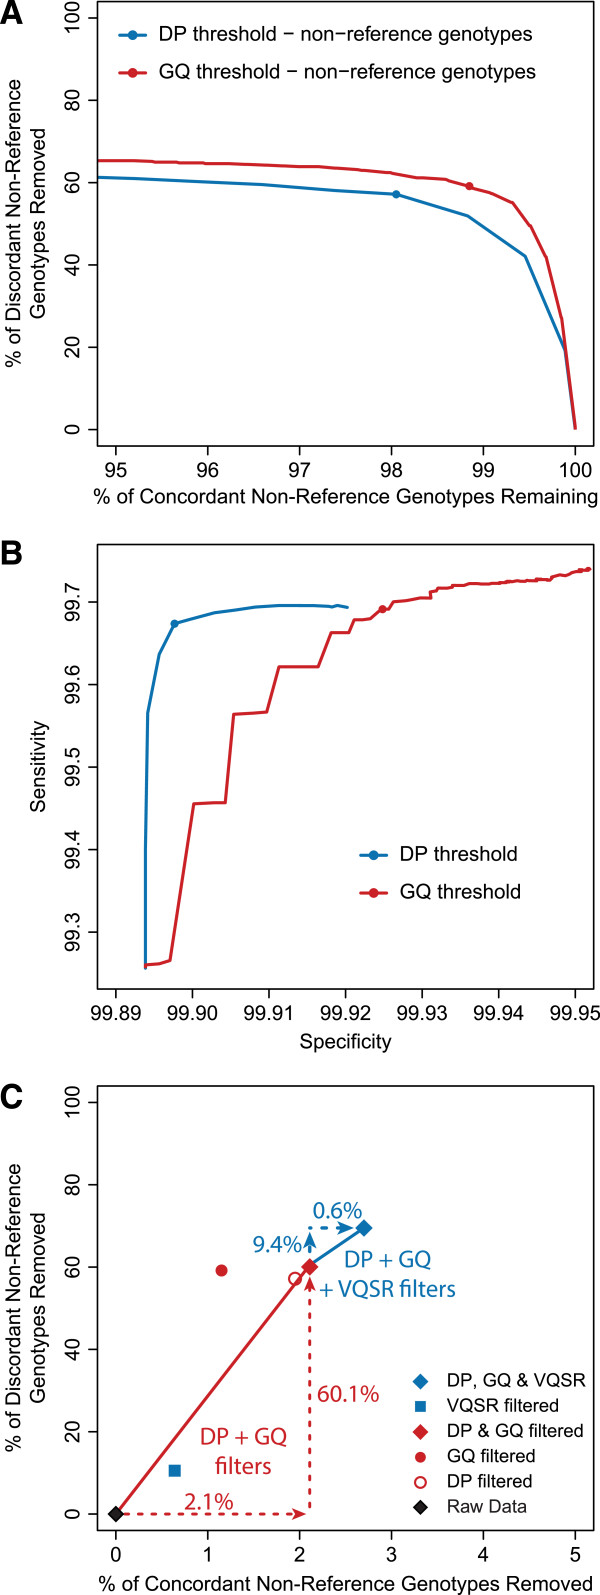
Improved concordance, sensitivity and specificity of WES data using genotype filters. Plots illustrate the non-reference concordance and sensitivity versus specificity between array and sequencing genotypes for 10 samples. A) The percent of non-reference discordant calls removed is plotted versus the percent of non-reference concordant calls retained at increasing quality thresholds. B) Sensitivity versus specificity is plotted at increasing quality thresholds. For A) and B), blue line represents changing DP thresholds and the red line represents change GQ thresholds. Chosen filter thresholds (DP ≥ 8 and GQ ≥ 20) are indicated by points on these lines. C) Summarizes the effect that the chosen genotype filters (both DP and GQ) have on non-reference concordant and discordant genotype calls with and without the VQSR filter.